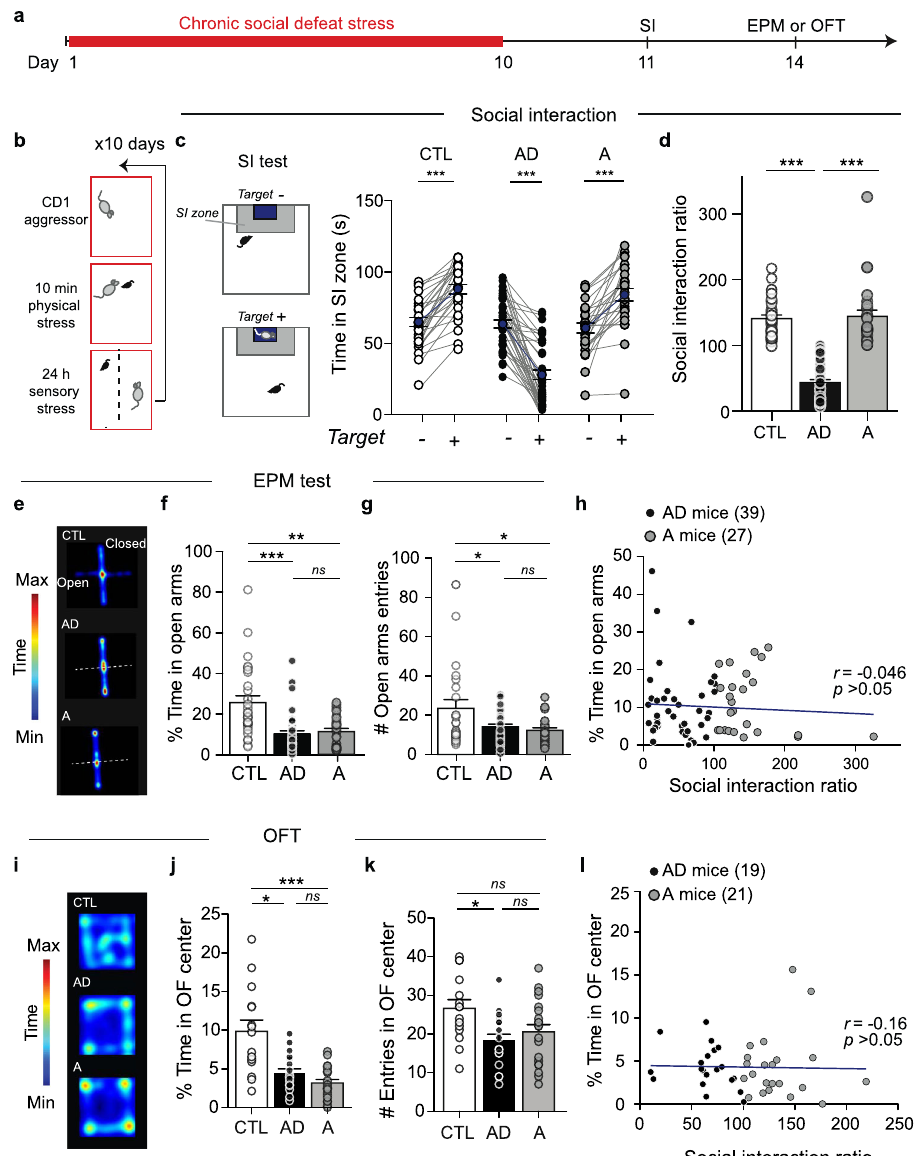
Fig. 1 CSDS induces anxiety-related behaviors independently of social avoidance behavior. a Experimental timeline for social interaction (SI) and elevated plus maze (EPM) or open fi eld (OFT) tests. b Schematic of CSDS paradigm. c SI behavior in stress-naïve control (CTL) and socially defeated mice: AD mice display depressive-like social avoidance behavior and anxiety-like phenotype, and A mice exhibit only anxiety-like behavior (see data panels below), blue circles represent mean ± s.e.m. (Paired t -tests, n = 28 CTL t = 9.02 p = 1.22e − 09, n = 39 AD t = 10.38 p = 1.27e − 12, and n = 27 A mice t = 6.78 p = 3.38e − 07, examined over 3 independent replicated experiments). d Resulting social interaction ratio, another way to analyze SI behavior that measures stable, relative time spent in SI zone (mean ± s.e.m., Kruskal – Wallis test, H 2/91 = 67.37; Z = 6.997 p < 0.001; Z = 6.80 p < 0.001; Z = 0.114 p = 0.99). e Heatmap representation of the time spent in EPM compartments in CTL, AD, and A mice. f Time in EPM open arms (Kruskal – Wallis test, H = 22.36; Z = 4.585 p < 0.001; Z = 3.432 p = 0.002; Z = 0.8381 p = 0.99) and g EPM open arm entries in AD and A mice compared to control mice 91 (ANOVA, F (2, 91) = 5.258 p = 0.007; t = 2.763 p = 0.01, t = 2.912 p = 0.09; t = 0.403 p = 0.69; n = 28 CTL, n = 39 AD and n = 27 A mice, examined over 3 independent replicated experiments, bars represent mean ± s.e.m.). h Pearson correlation analyses of the time in open arms with the social interaction behaviors of socially stressed mice ( n = 66, p = 0.74). i Heatmap representation of the time spent in the open fi eld arena in CTL, AD, and A mice. j Time (%) in open fi eld center (Kruskal – Wallis test, H 2/52 = 17.55, p = 0.0001; Z = 2.728 p = 0.02; Z = 4.168 p = 0.0001; Z = 1.474 p = 0.42) and k number of open fi eld center entries (ANOVA, F 2/52 = 4.831 p = 0.01; t = 3.032 p = 0.01; t = 2.293 p = 0.05; t = 0.859 p = 0.39; n = 15 CTL, n = 19 AD and n = 21 A mice, bars represent mean ± s.e.m.). l Pearson correlation analyses of the time in open fi eld center with the social interaction behaviors of socially stressed mice ( n = 40, p = 0.017). In all panels, two-sided statistical analyses and post hoc tests were performed, * p < 0.05, ** p < 0.01, *** p < 0.001, ns p > 0.05, for n number of C57BL6/J mice. See also Supplementary Figs. 1 and 2.